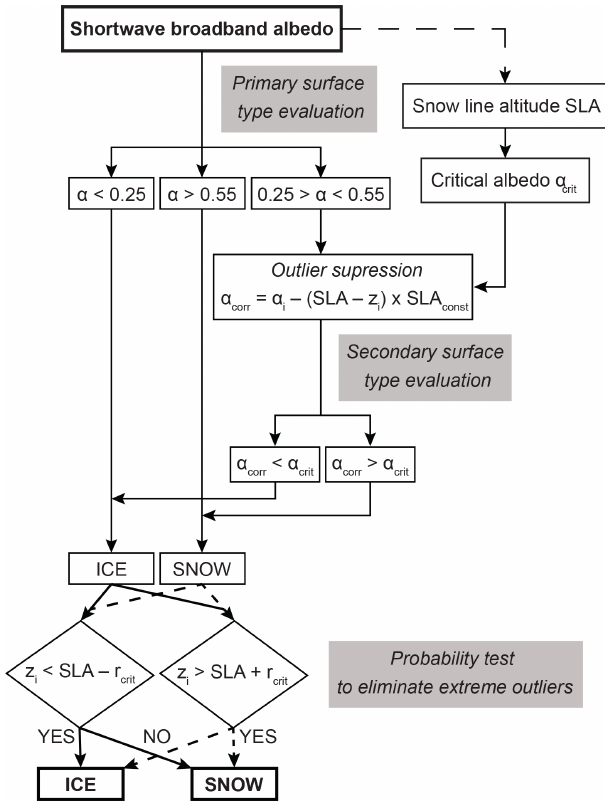
Figure 2. Flow chart of the methodology applied to evaluate the surface type (snow and ice) of every glacier grid cell based on the derived shortwave broadband albedo. For further explanation please see